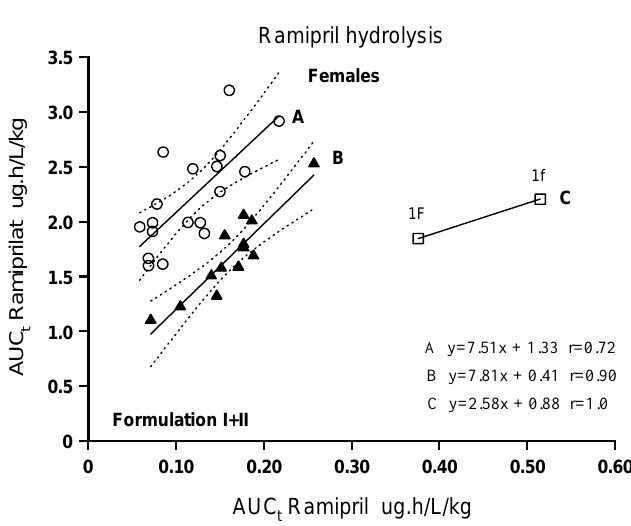
FIGURE 4. AUC t/ kg ramipril plotted vs. the AUC t /kg of the metabolite ramiprilat after the oral administration of 5 mg ramipril (Formulation I + II in females). Two apparent subgroups can be distinguished, each with a similar slope of the regression line ( p = 0.51) but with different Y- intercepts ( p < 0.0001). Subject 1 hydrolyses ramipril very slowly (F = first administration and f = second administration).